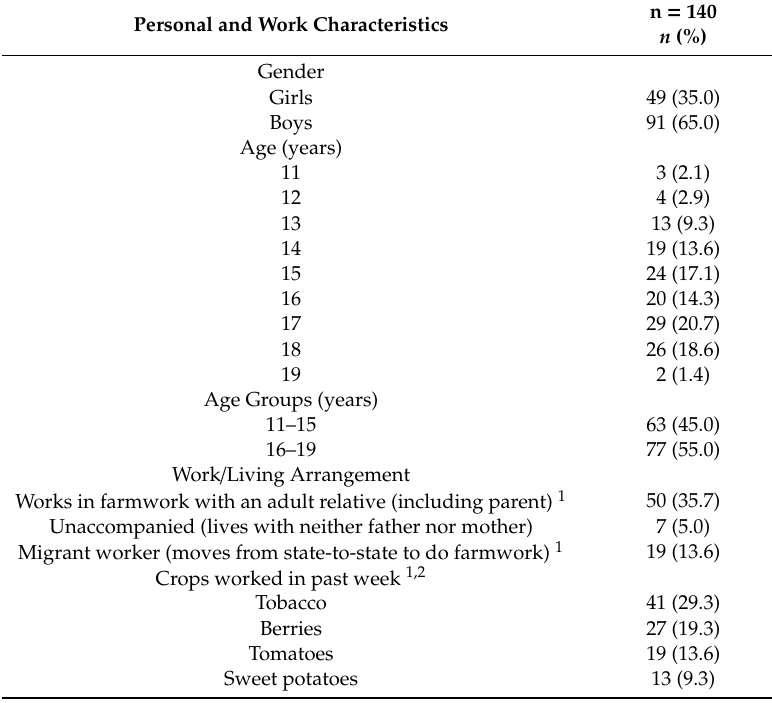
Table 1. Participant personal, work and health characteristics, hired Latinx child farmworkers in North Carolina,